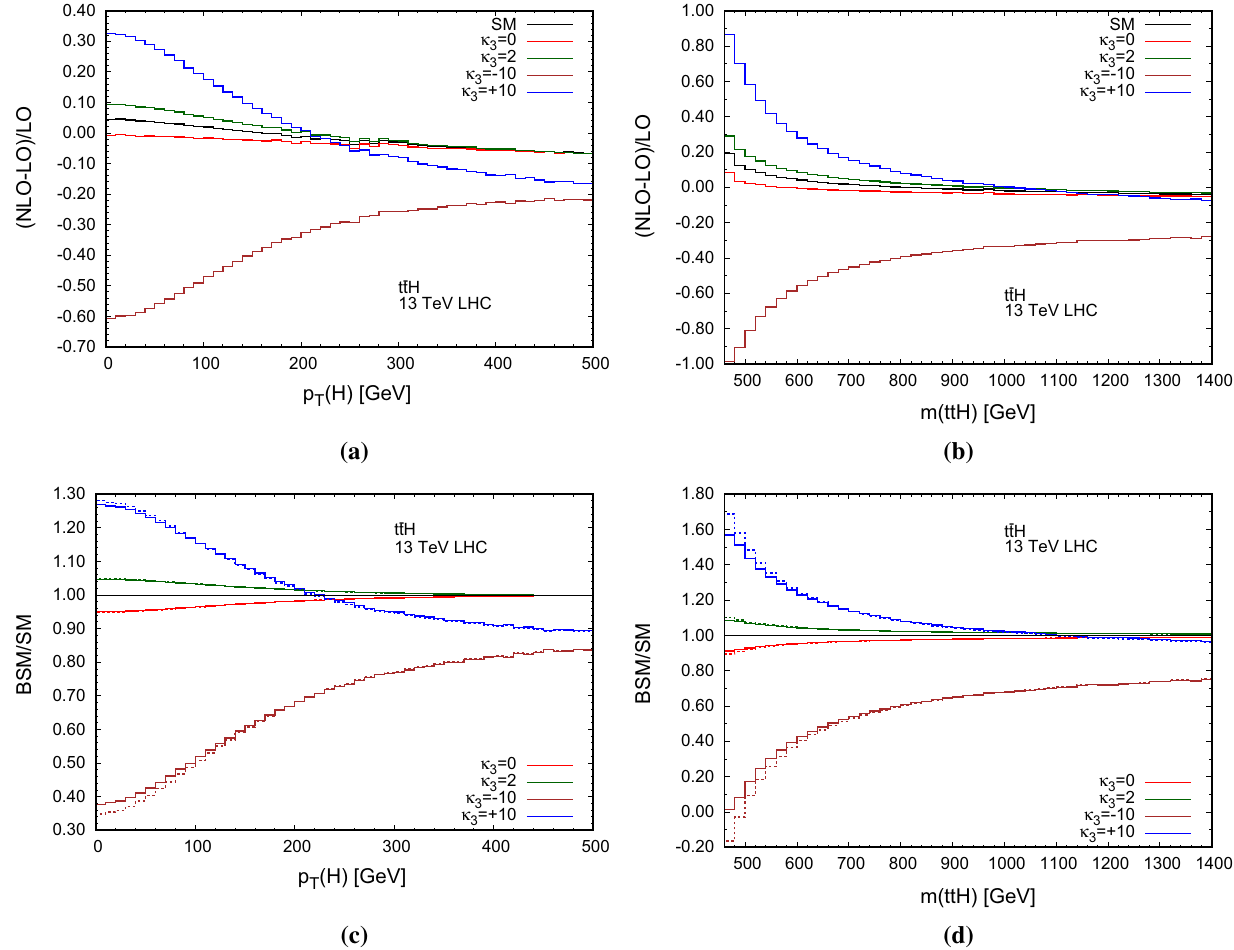
− σ )/σ LO LO ratio for different values of NLO